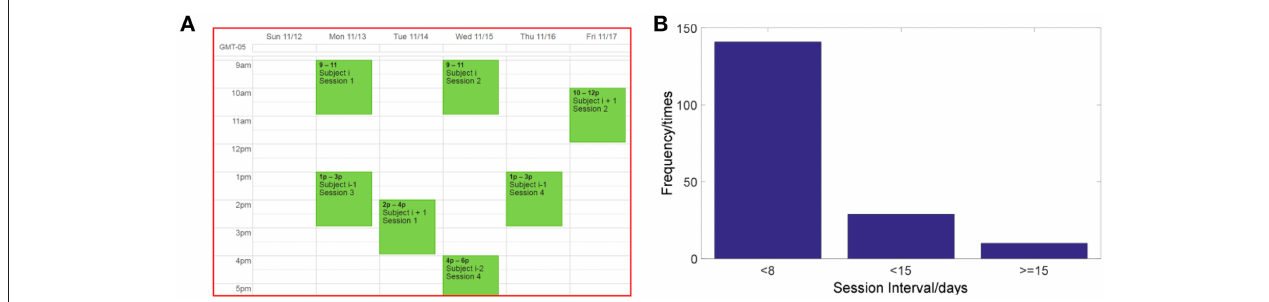
FIGURE 2 | Schematic representation of the experimental schedule. (A) Scheme of subjects’ recruitment and experimental schedule. (B) The statistics of inter-session interval for all sessions and subjects.